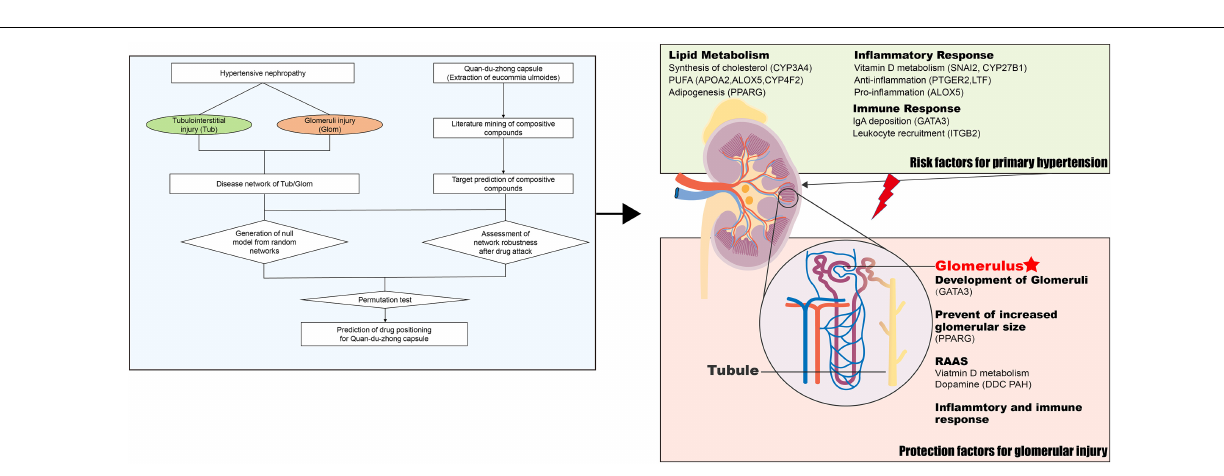
FIGURE 6 | QDZJN against HN via renal protection and reduction of hypertension risk. Left part is the schematic diagram of tissue location of drug based on network robustness. Possible mechanism of QDZJN protect against glomerular injury of HN was summarized in right